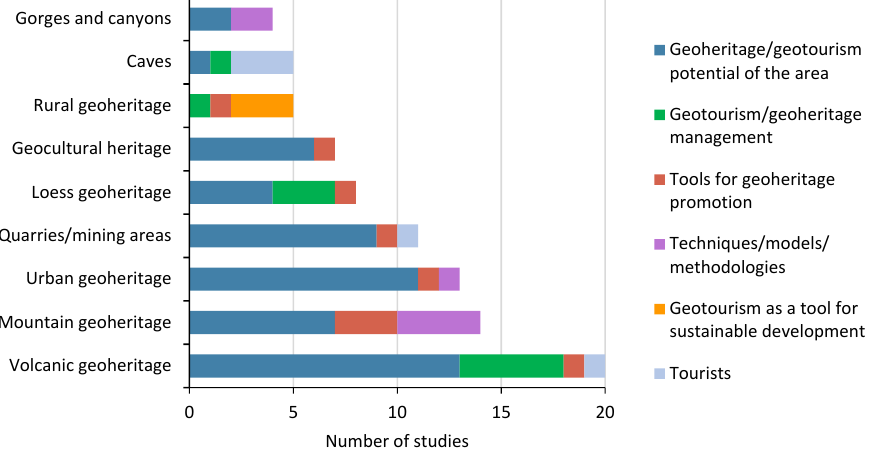
Figure 5. The major areas of geoheritage focus within geotourism research.